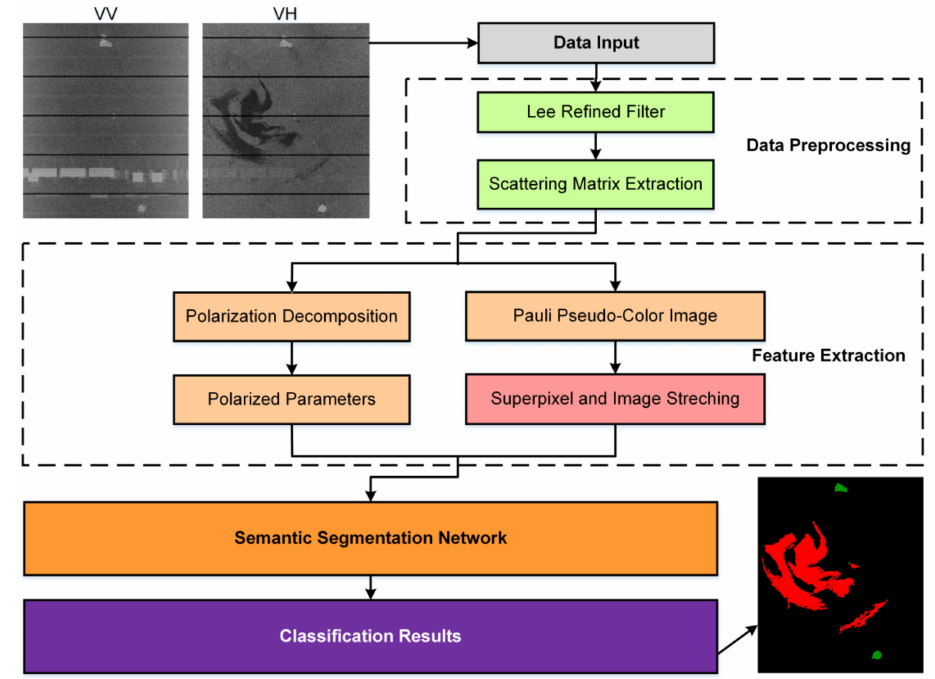
Figure 1. Overall flowchart of the proposed oil spill detection algorithm.